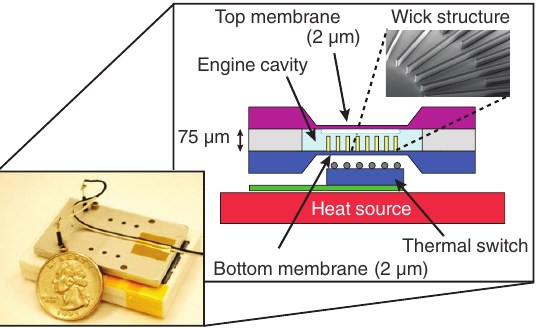
Figure 10. Thermal energy harvesting: P3 MEMS-based heat engine [82]. The inset shows the schematic sketch of the